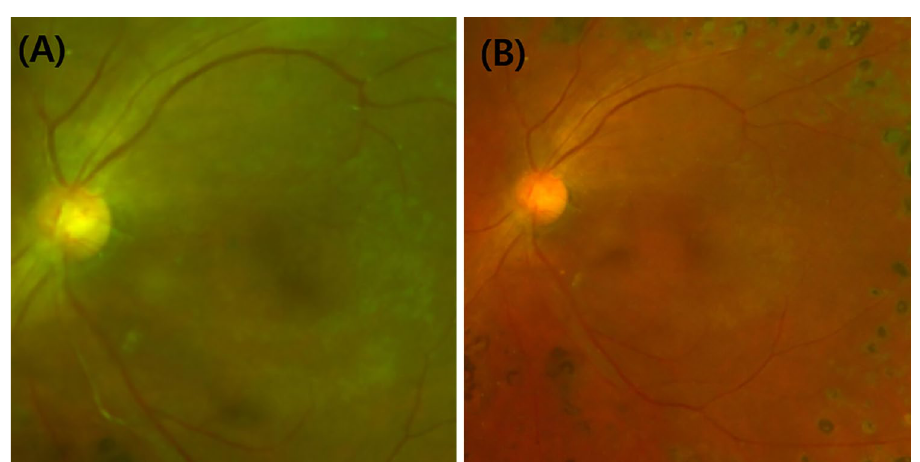
Figure 3. Fundus photographs of case 1 at ( A ) 6 months and ( B ) 18 months after the final IVAI. NVD regeneration and VH recurrence were not observed during the 18-month